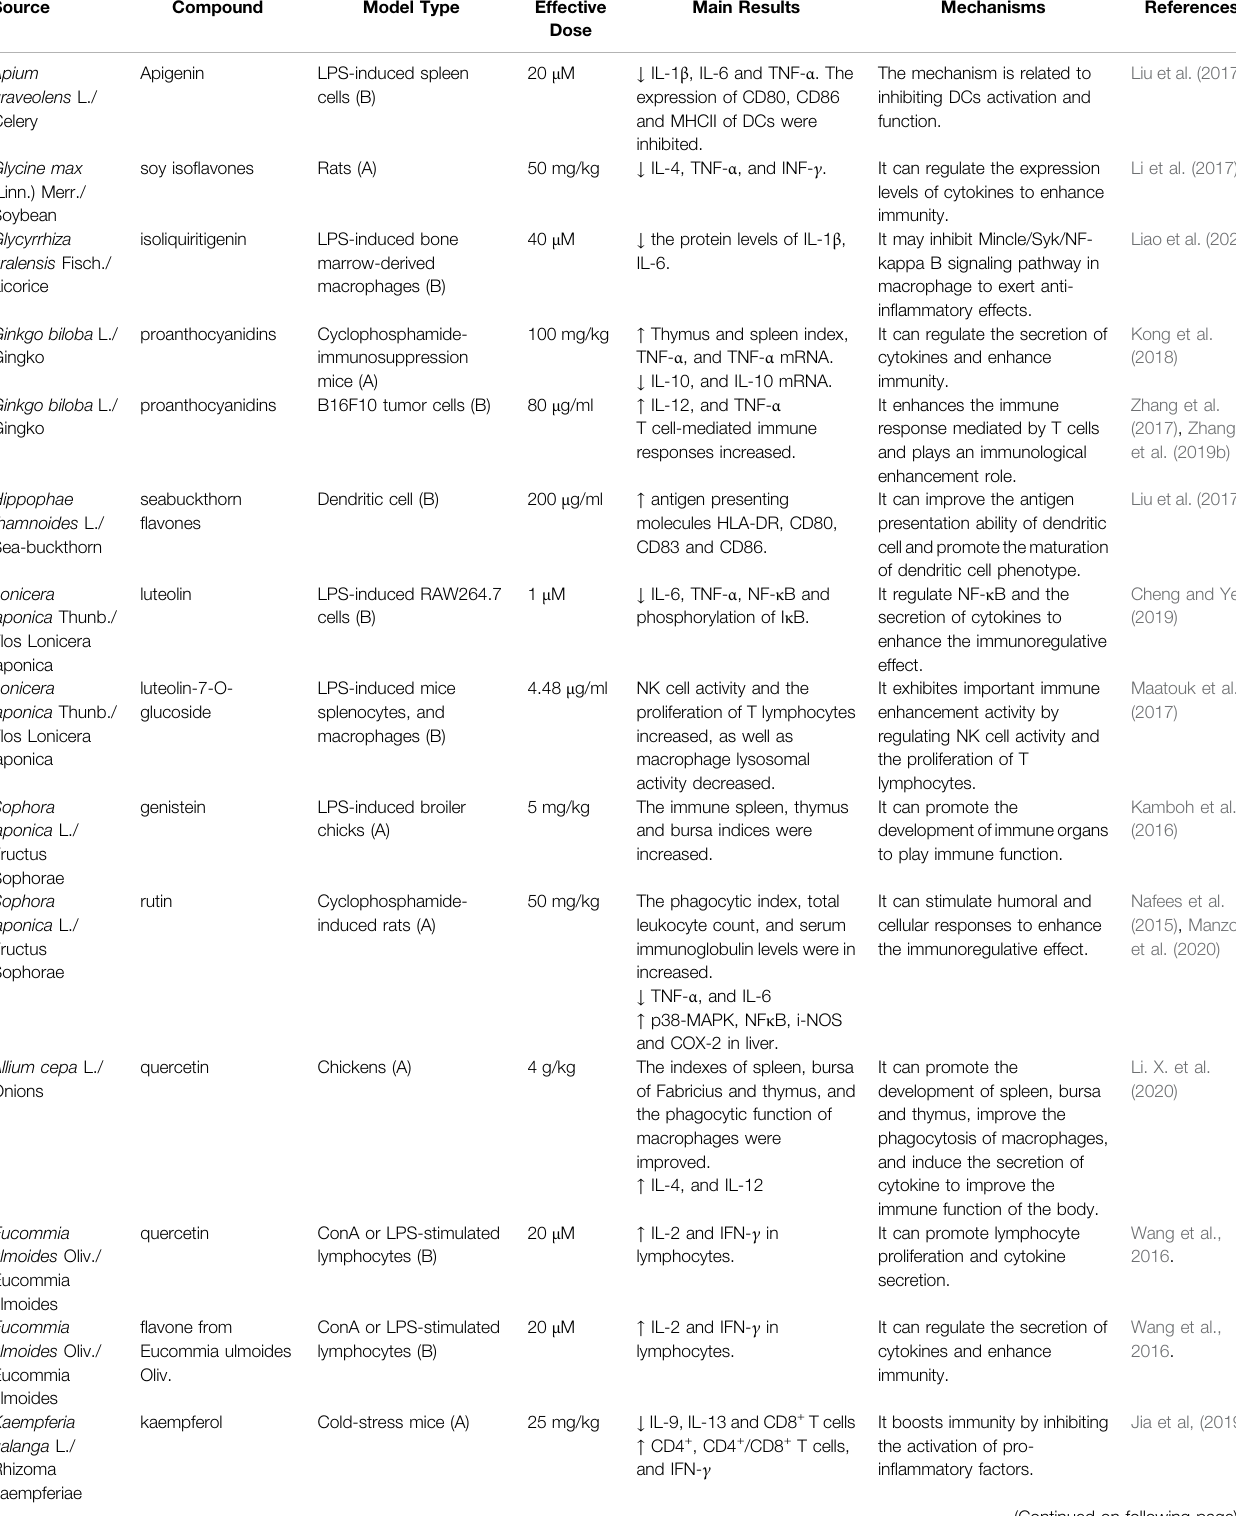
TABLE 3 | Flavonoids components in plant-based functional foods on immune